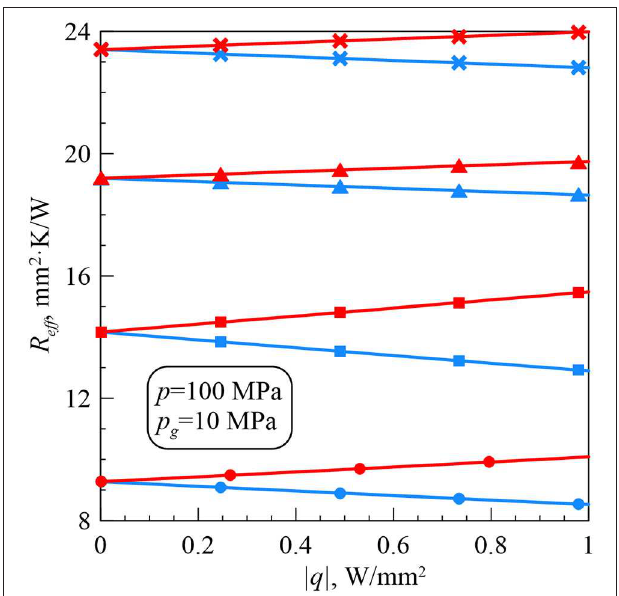
FIGURE 5 | The effective thermal contact resistance R eff vs. the heat flux